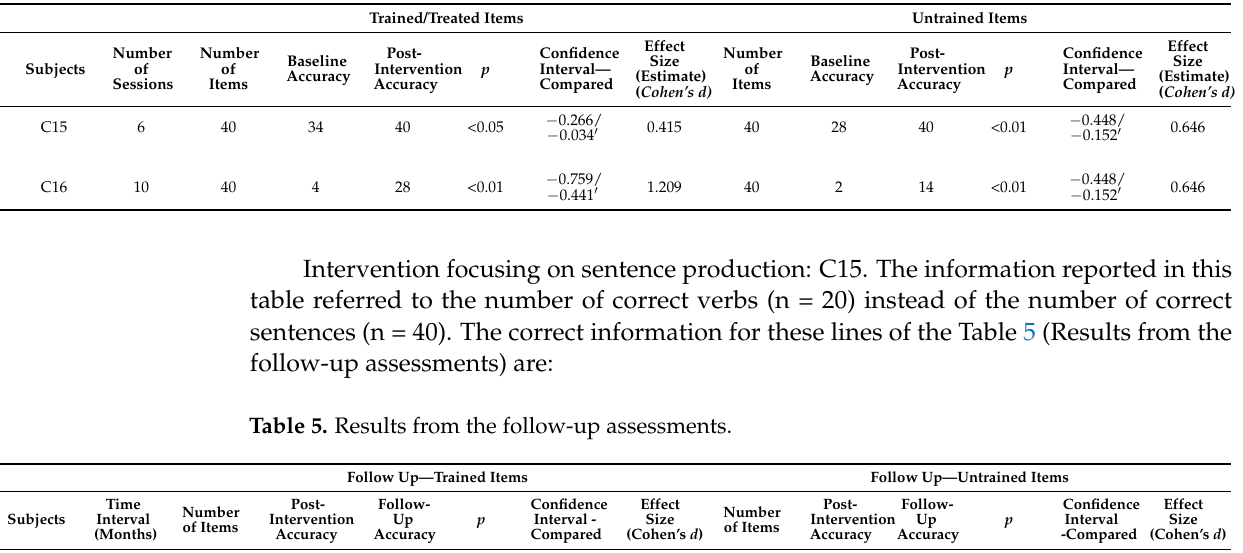
Table 3. Results from the intervention programs.